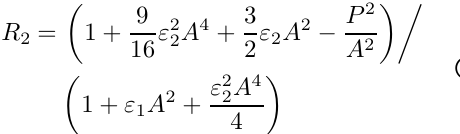
Fig. 3. Same as Fig. 2, but for the case ε 1 = 5 . 78828 , ε 2 = 1 . 25469 , ε 3 c = 0 . 006133 , ε 3 d = 0 . 0003978 , δ = 0 . 02 and P = 0 . 2 , corresponding to the second